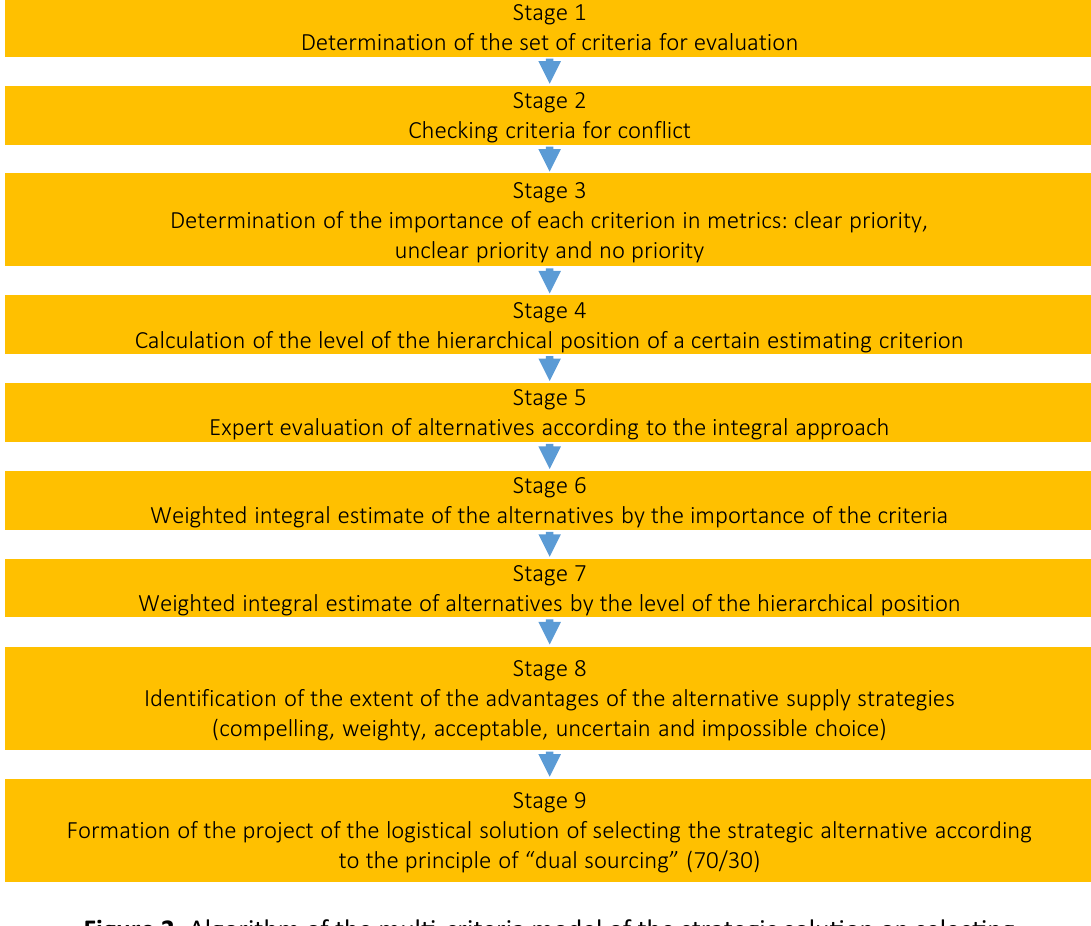
Figure 2. Algorithm of the multi-criteria model of the strategic solution on selecting the suppliers at the market of the material